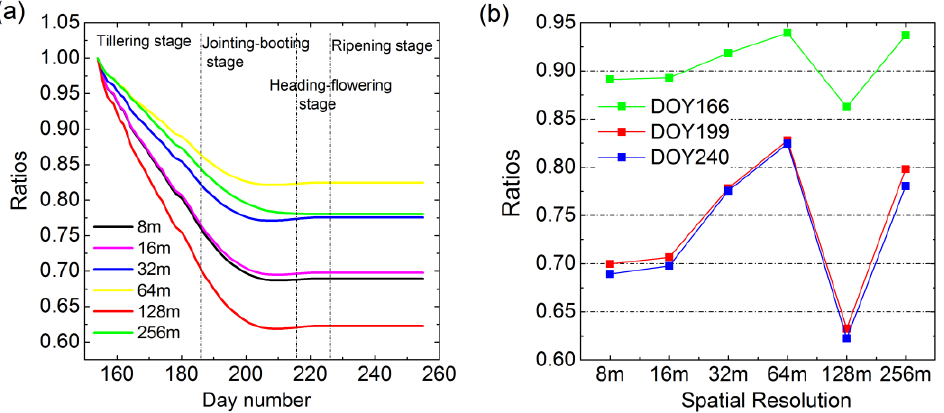
Figure 7. ( a ) Dynamic variations about the ratios of WRT (dry weight of roots) for Area A and Area B; and ( b ) the ratios of WRT (WRTA/WRTB) in the two study sites originating from the GF-1 (8 m) sensor and the aggregation of the GF-1 8 m image at coarser spatial resolutions (16 m, 32 m, 64 m, 128 m, 256 m) from various acquisition times (DOY 166, DOY 199, and DOY